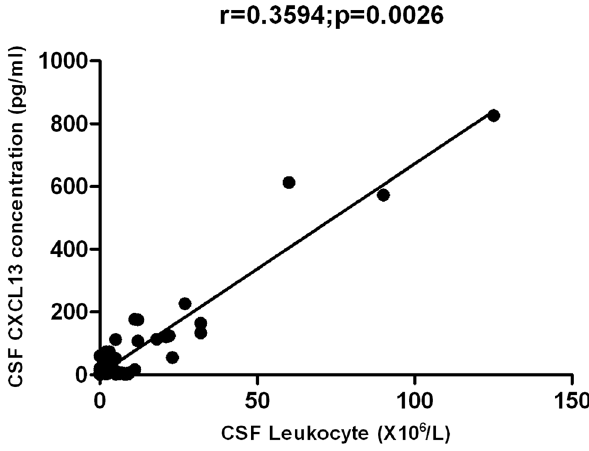
Figure 1: The leukocyte count in CSF was positively related to the